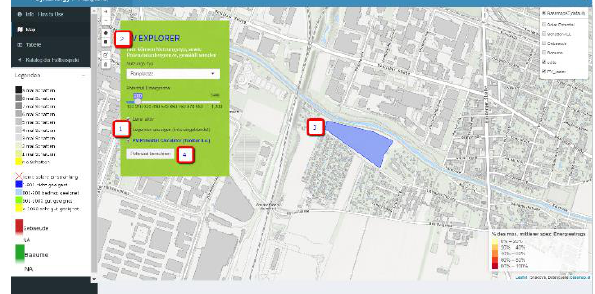
Figure 1. PV-Potential Calculator-Edit © AIT 2018